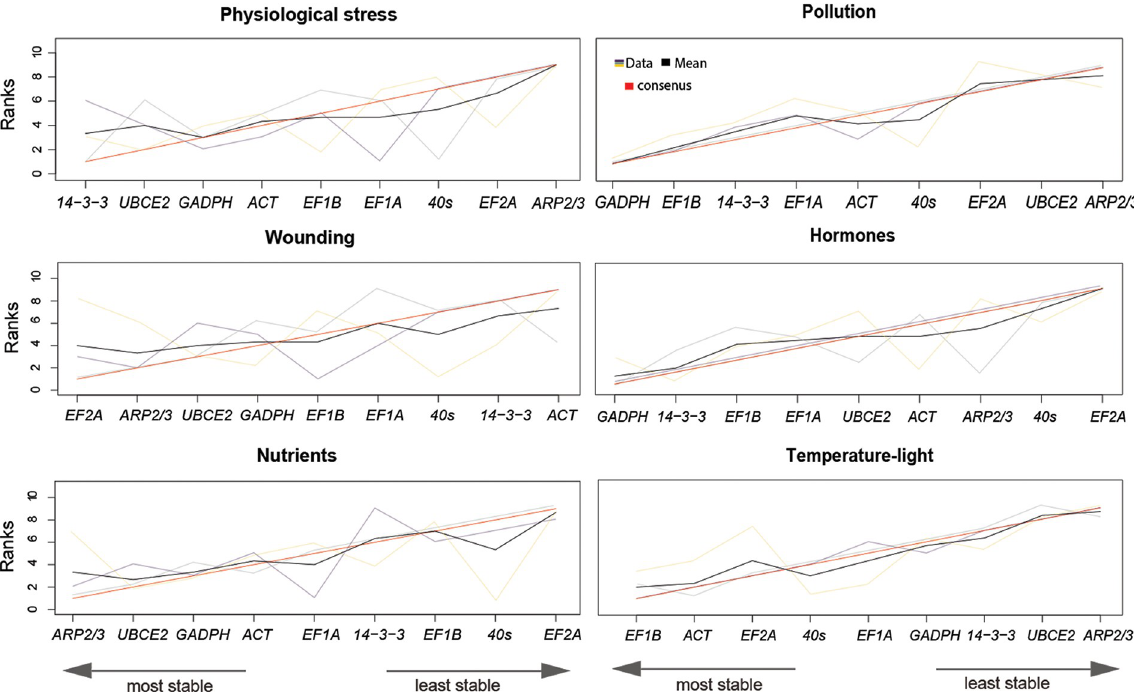
Fig 3. Optimal stability ranking of candidate reference genes using geNorm, NormFinder, BestKeeper, and rank aggregation method. Gene ranks from the three stability algorithms are shown by treatment group. Line colors represent: purple (geNorm), green (NormFinder), yellow (BestKeeper), black (mean rank), and red (consensus